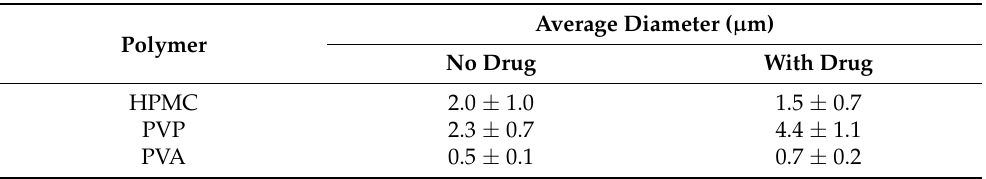
Figure 3. Distribution of the diameter of electrospun fibers prepared from PVP with and without the drug. Table 2. Diameter of the fibers spun from the polymers used in the study and the effect of the incorporation of the drug into them.